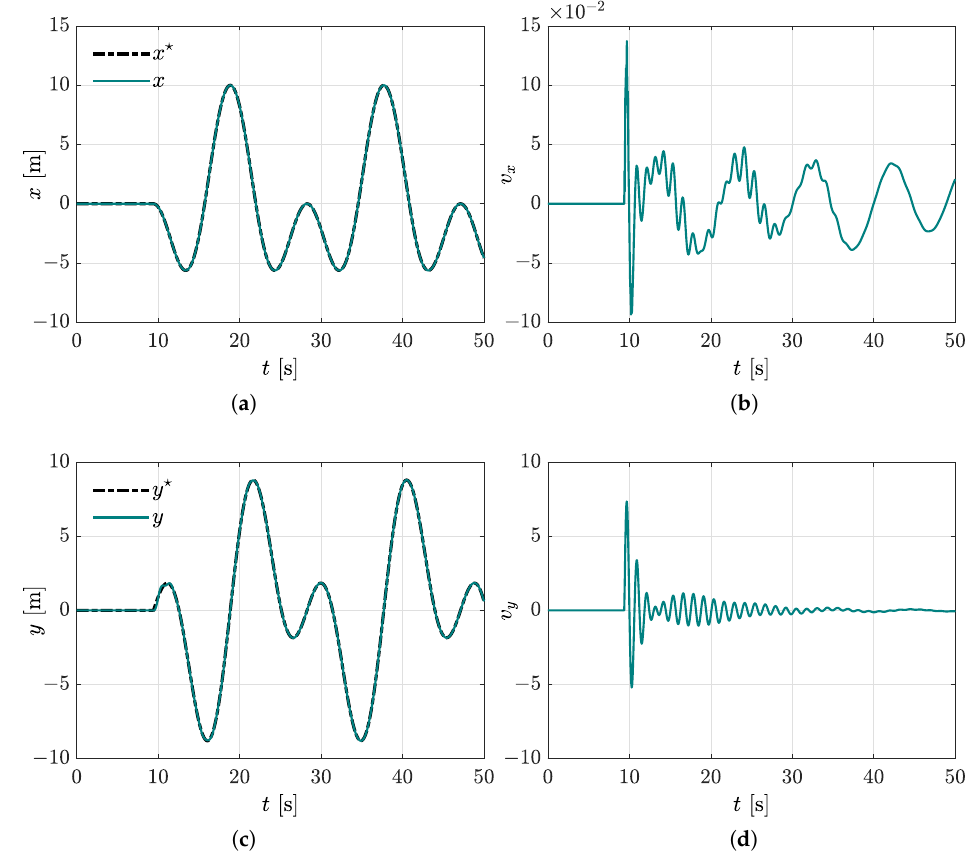
Figure 9. Controlled underactuated dynamics, case 2.1. ( a ) Desired x (cid:63) position tracking. ( b ) Virtual controller v x . ( c ) Desired y (cid:63) position tracking. ( d ) Virtual controller v y